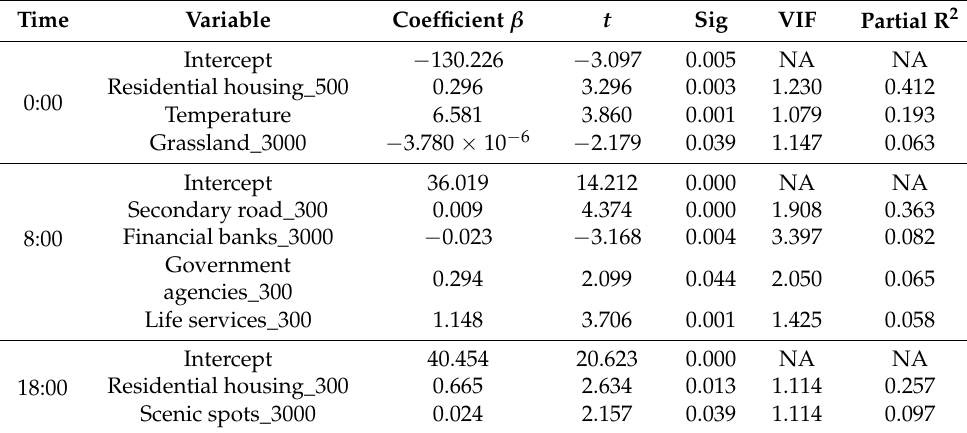
Table 6. LUR models at different times during a summer working